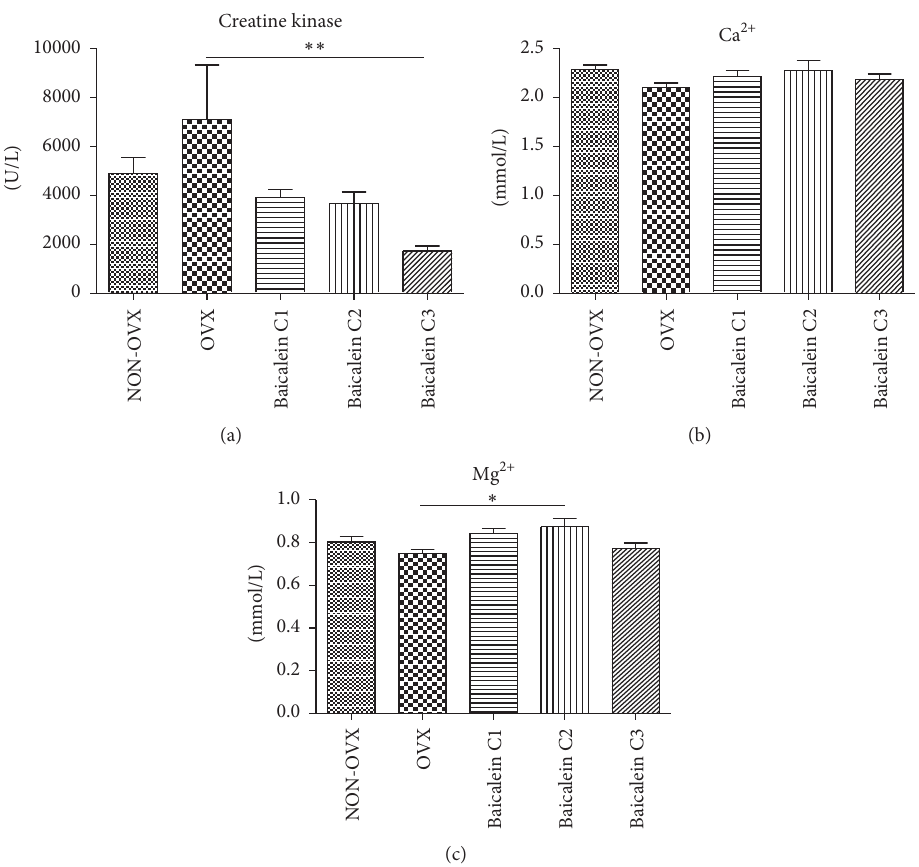
Figure 8: Serum creatine kinase, calcium, and magnesium levels. Compared with the OVX group, the C3 group had a significantly lower creatine kinase level ((a), 𝑛 = 48 ), whereas the calcium values were not statistically significant ((b), 𝑛 = 48 ). The C2 group showed a significantly higher level of magnesium when compared with the OVX group ((c), 𝑛 = 48 ). ∗ 𝑝 < 0.05 and ∗∗ 𝑝 < 0.01 indicate significant